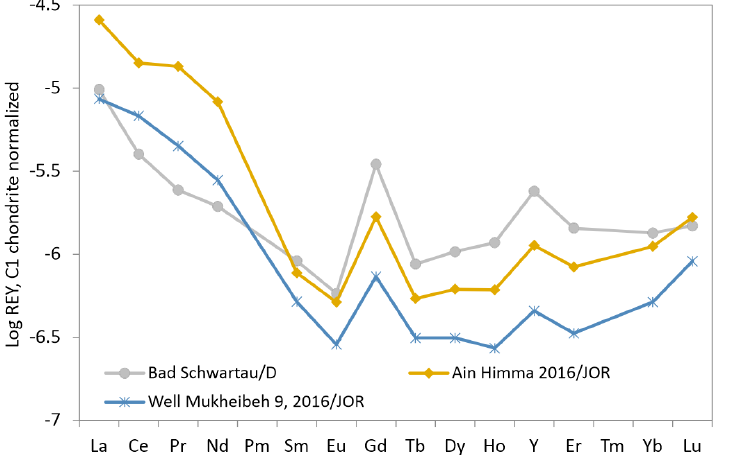
Figure 13. REY patterns showing greater Gd anomalies than Y anomalies. Samples are from wells or springs which cannot be affected by anthropogenic contamination (Bad Schwartau: unpublished; Ain Hima and Mukheibeh 9 in 2016 [53].